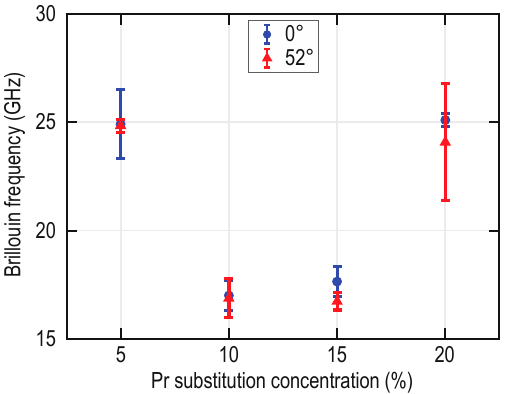
Figure 4. Distributions of the reliably extracted BFs for the two probe angles of incidence, ψ = 0° (blue) and ψ = 52° (orange), and for the different Pr substitution concentrations: ( a ) 5%, ( b ) 10%, ( c ) 15%, and ( d ) 20%. Gaussian fits of the distributions are also shown.